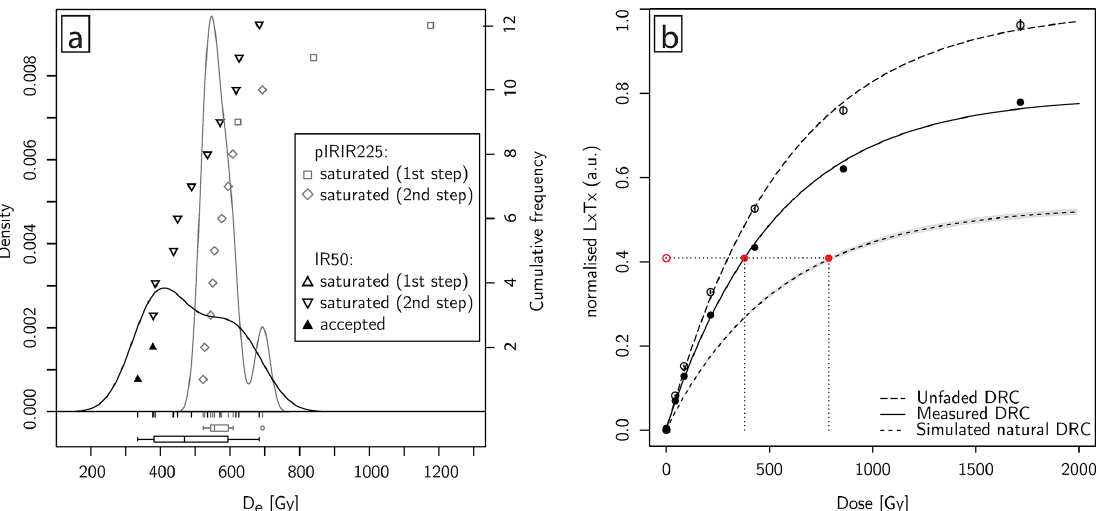
Figure B1. Analysis of luminescence measurements for sample RE-03, using R.Luminescence (Kreutzer et al., 2012). (a) Plot of the apparent D e distribution for the IR50 (triangle symbols) and pIRIR225 (square symbols) signals. (b) Dose response curves (DRCs) of one of the two aliquots that passed both steps of saturation testing. This plot shows both the measured laboratory DRC and the modeled/simulated fading-corrected DRC based on Kars et al.